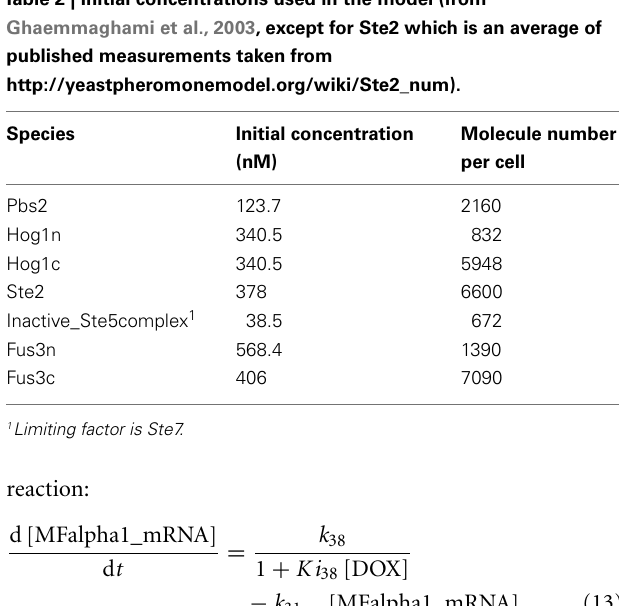
Table 2 | Initial concentrations used in the model